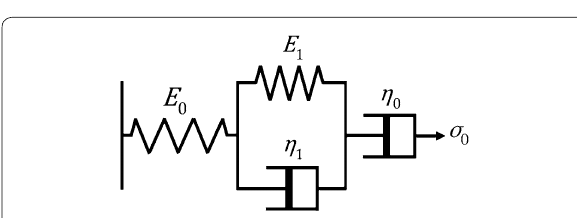
Fig. 3 Schematic diagram of the four-element Burgers